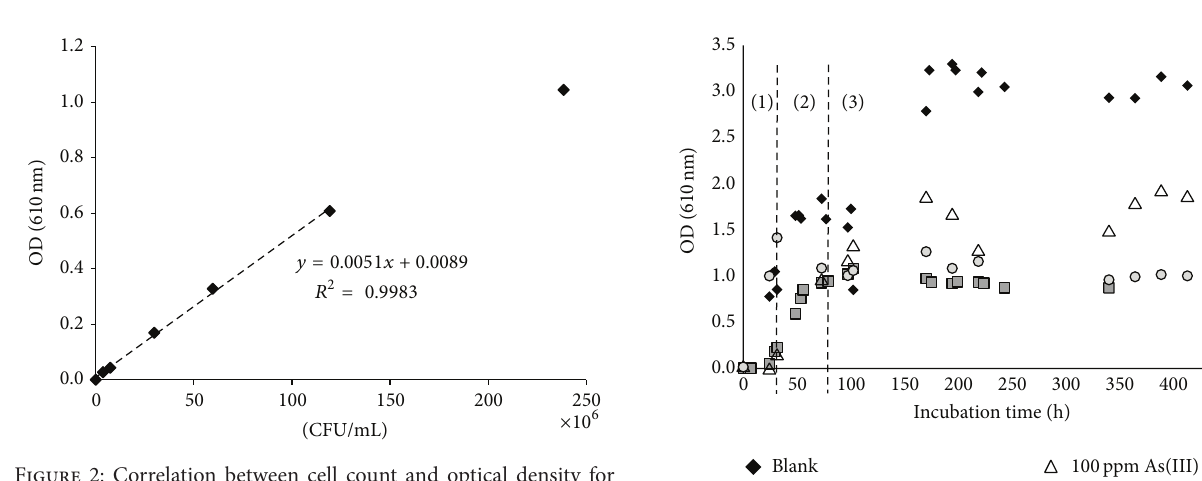
Figure 2: Correlation between cell count and optical density for Bacillus mucilaginosus .